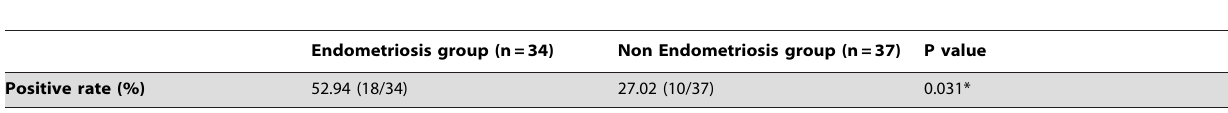
Table 2. Rate of chronic endometritis in the endometriosis and non-endometriosis